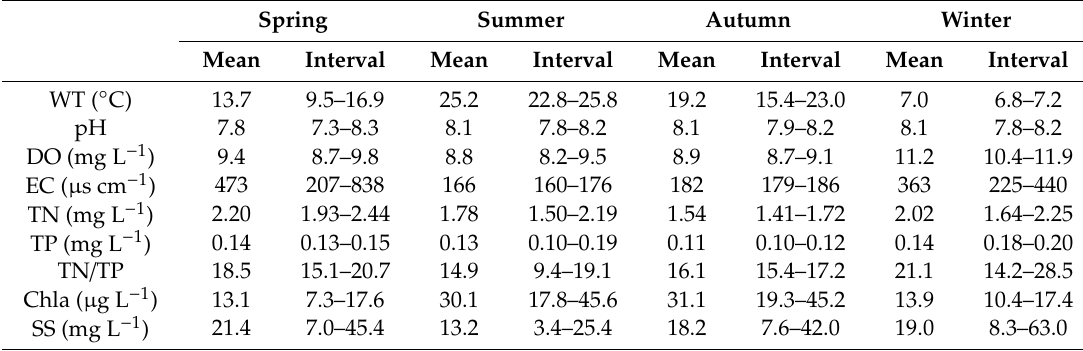
Table 1. Means and ranges (Min-Max) of limnological variables in the epilimnion of the Qingcaosha Reservoir in 2014 (n = 30). Spring